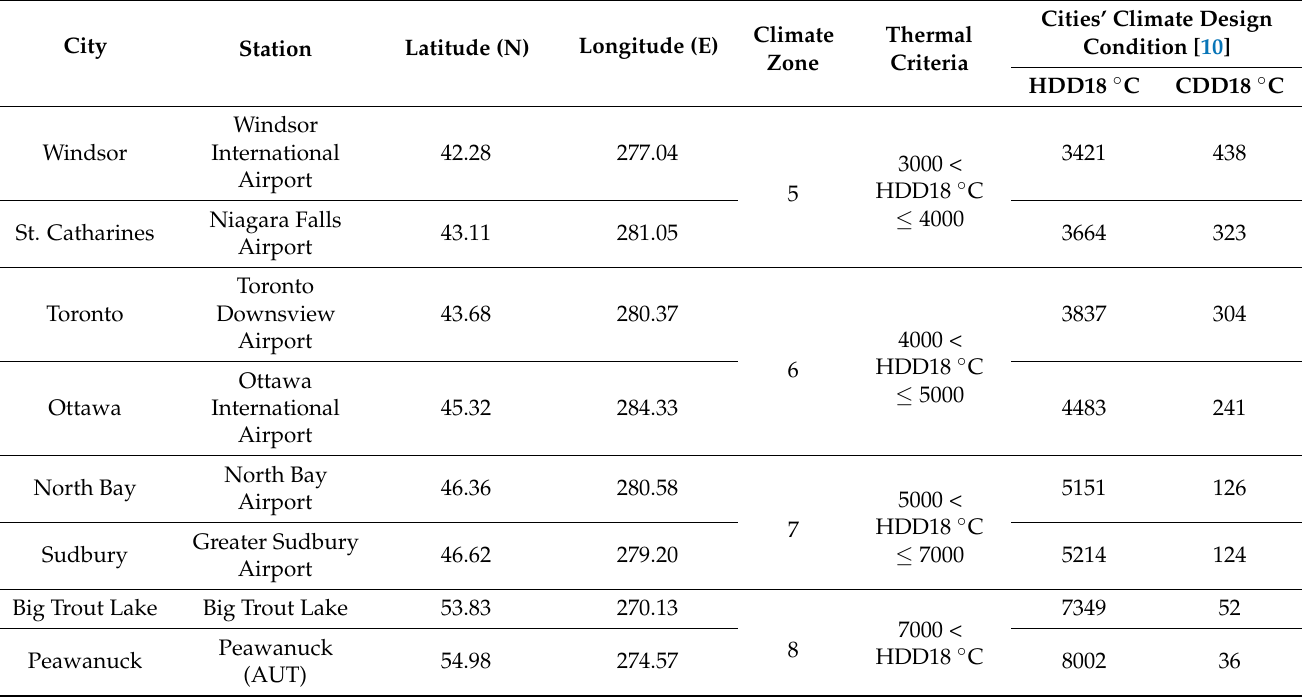
Figure 1. The location of eight selected cities. Table 1. Climate zone information of eight cities.